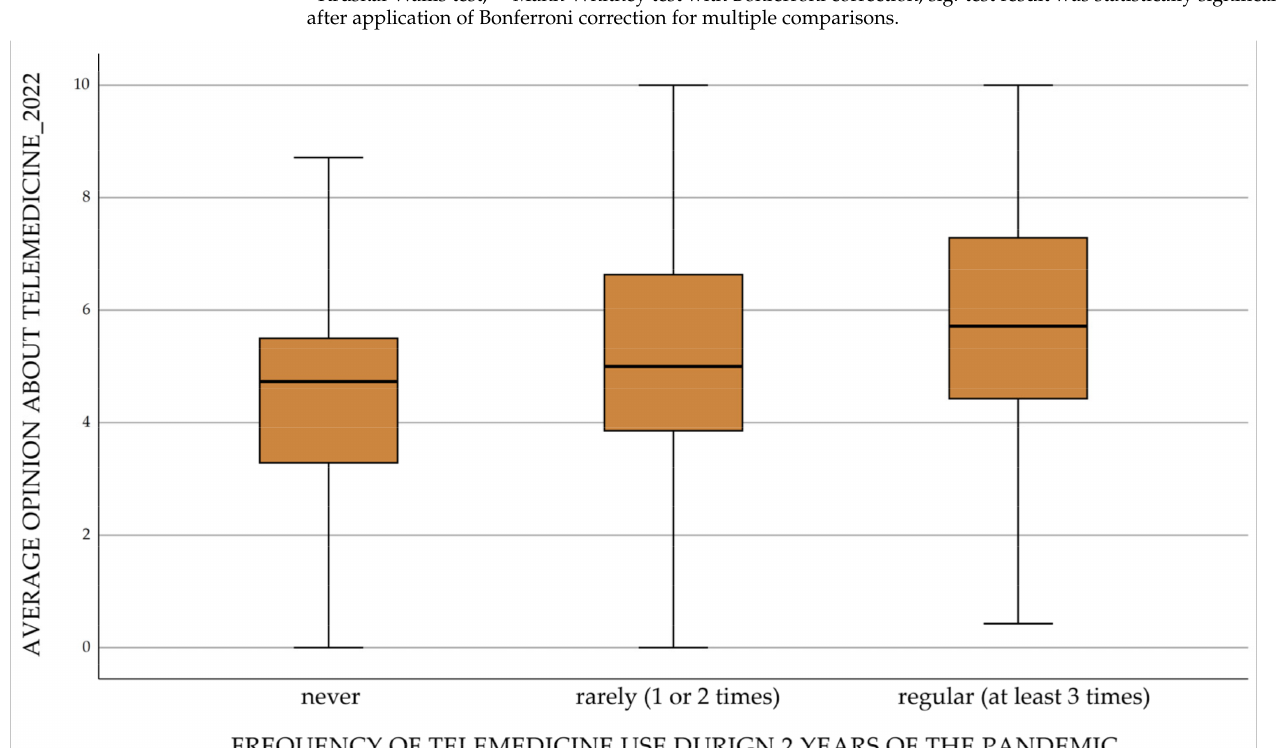
Figure 5. Average opinion on telemedicine after two years of the